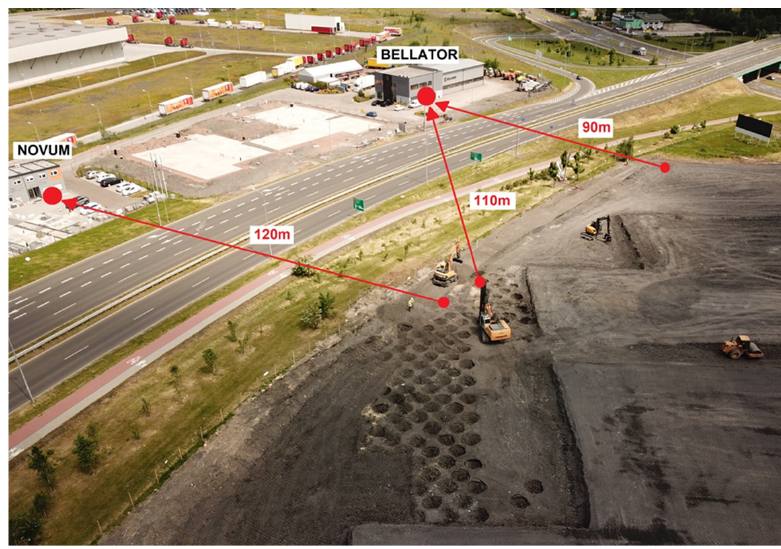
Figure 21. Vibration measurement area—control of the influence on the gabions’ substrate. (graphic by P. Dobrzycki)